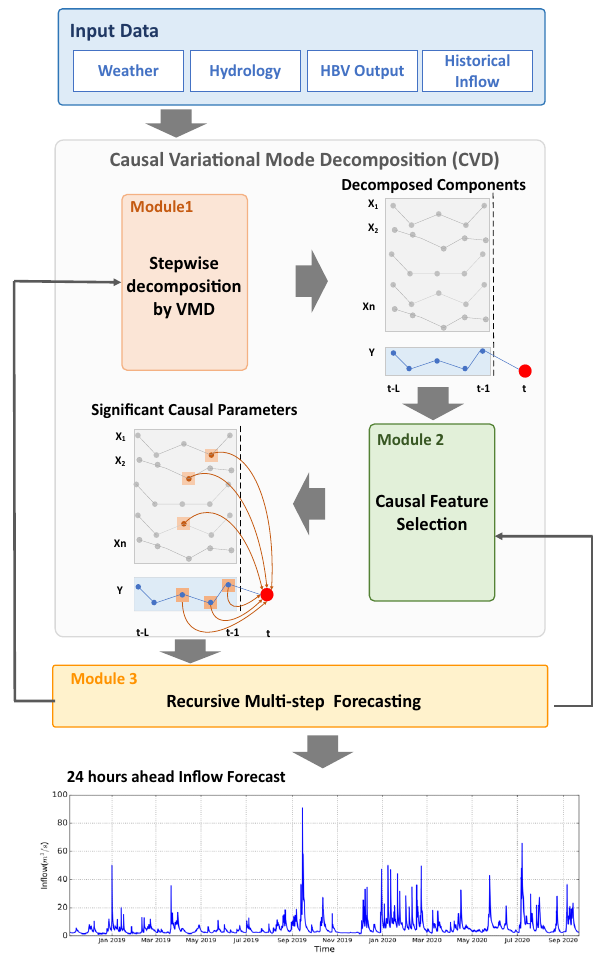
Figure 3. Overview of the proposed CVD framework: Module 1 decomposes the 33 inputs to n = m ∗ N inputs. Module 2 output is the lag values of variables with a maximum contribution to the next step of inflow Y . Module 3 output is 24 ahead of inflow forecast by using a one-step ahead trained